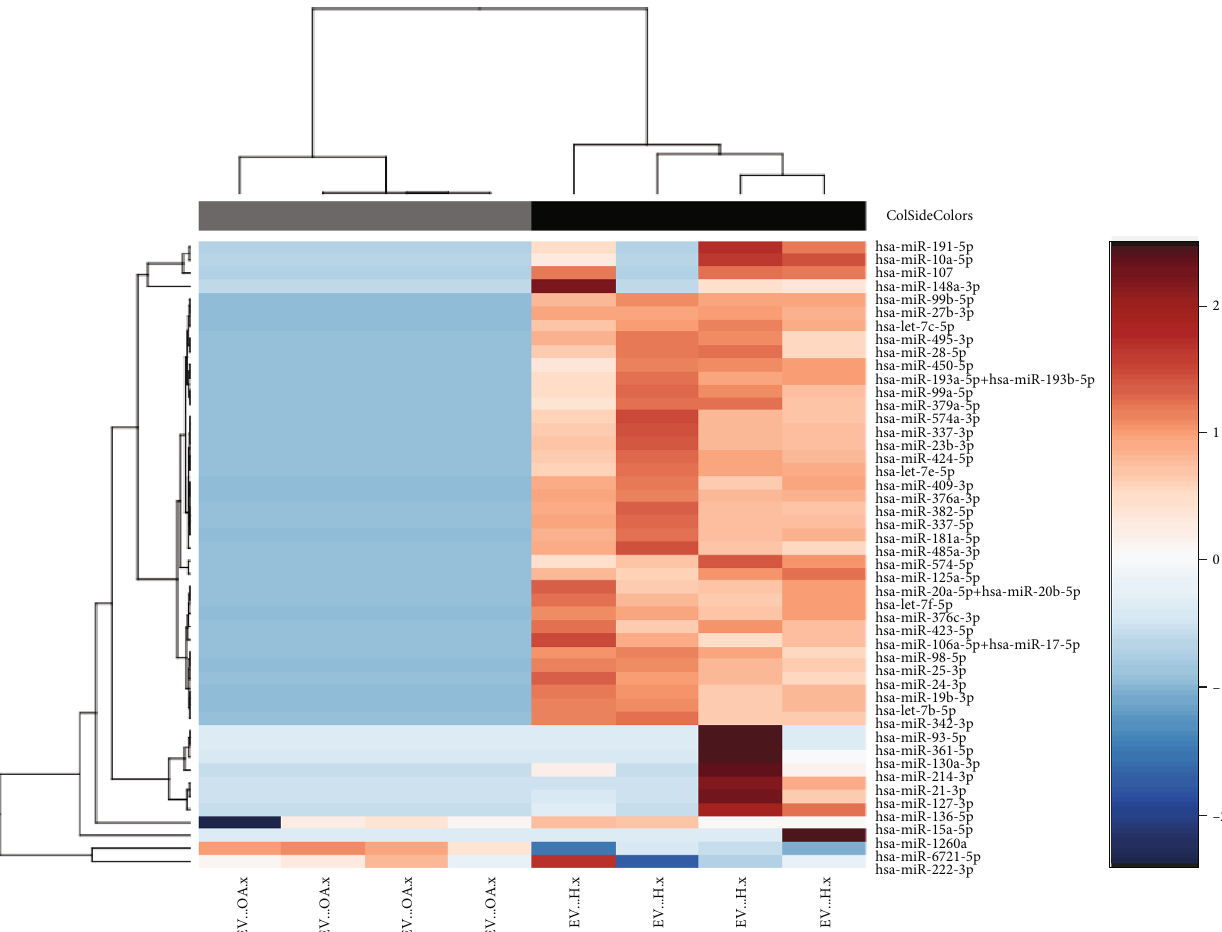
Figure 4: OA-EV and H-EV miRNA expression pro fi ling using NanoString technology. Heatmap showing unsupervised hierarchical clustering of signi fi cantly di ff erentially expressed microRNAs ( p < 0 : 05 , n = 48 ), based on normalized digital expression counts in OA- EVs vs. H-EVs. Each column represents an individual sample. Relative expression changes are indicated by the colour key (red: high; blue: low). OA-EVs are depicted by grey shading, while H-EVs are depicted by black